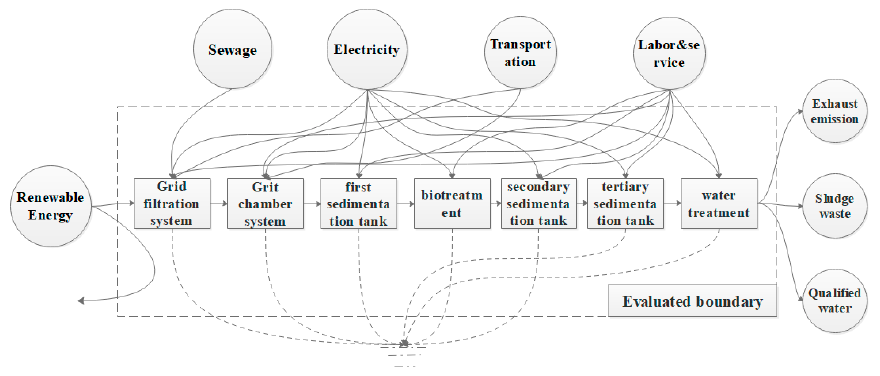
Figure 2. The emergy diagram of the new sewage treatment plant.